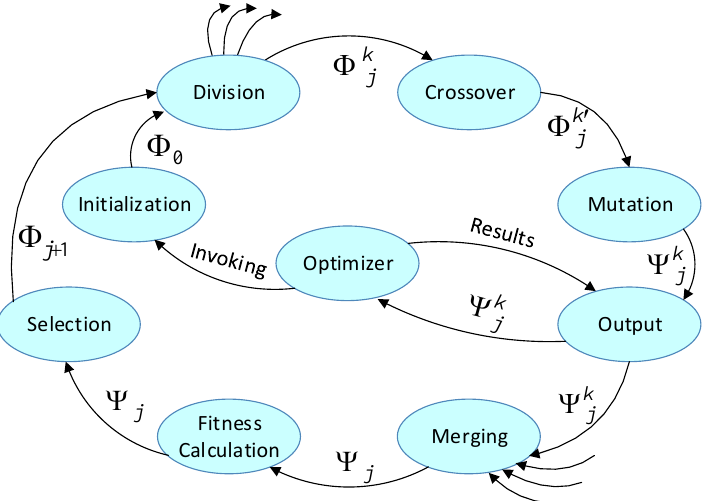
Figure 7. Procedure for the parallel genetic algorithm of the model-based